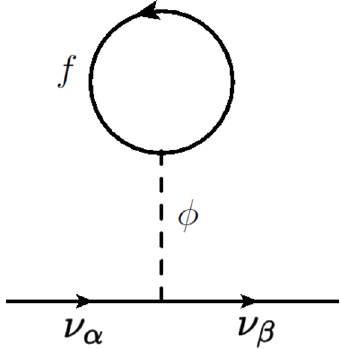
Figure 19 . Neutrino self-energy diagram in the background of fermion f = e or N , the